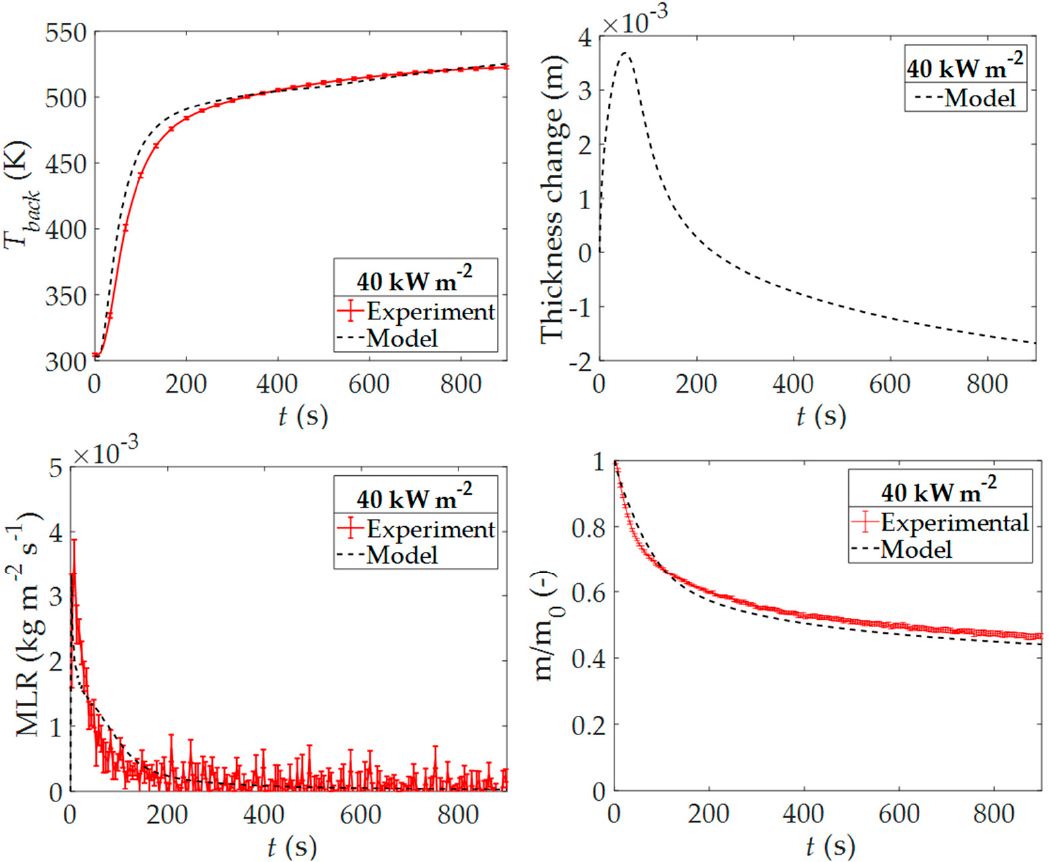
Figure A2. Mean experimental results and model predictions for the CAPA II tests performed on the PIR foam at 40 kW m − 2 of set radiant heat flux.